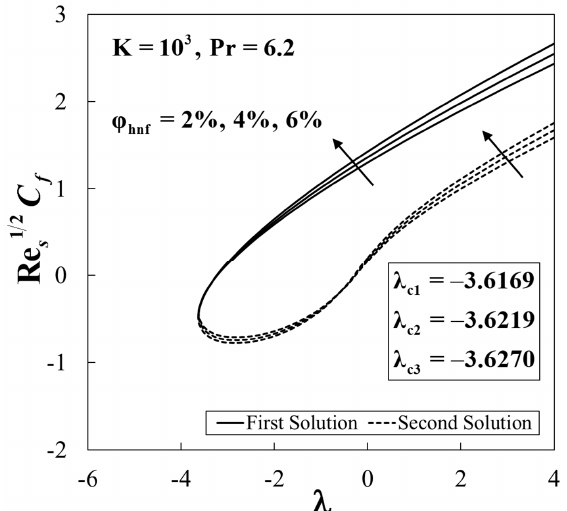
Figure 2. Variation of the skin friction coefficient Re 1/2 s C f against the mixed convection parameter λ for different values of ϕ hnf